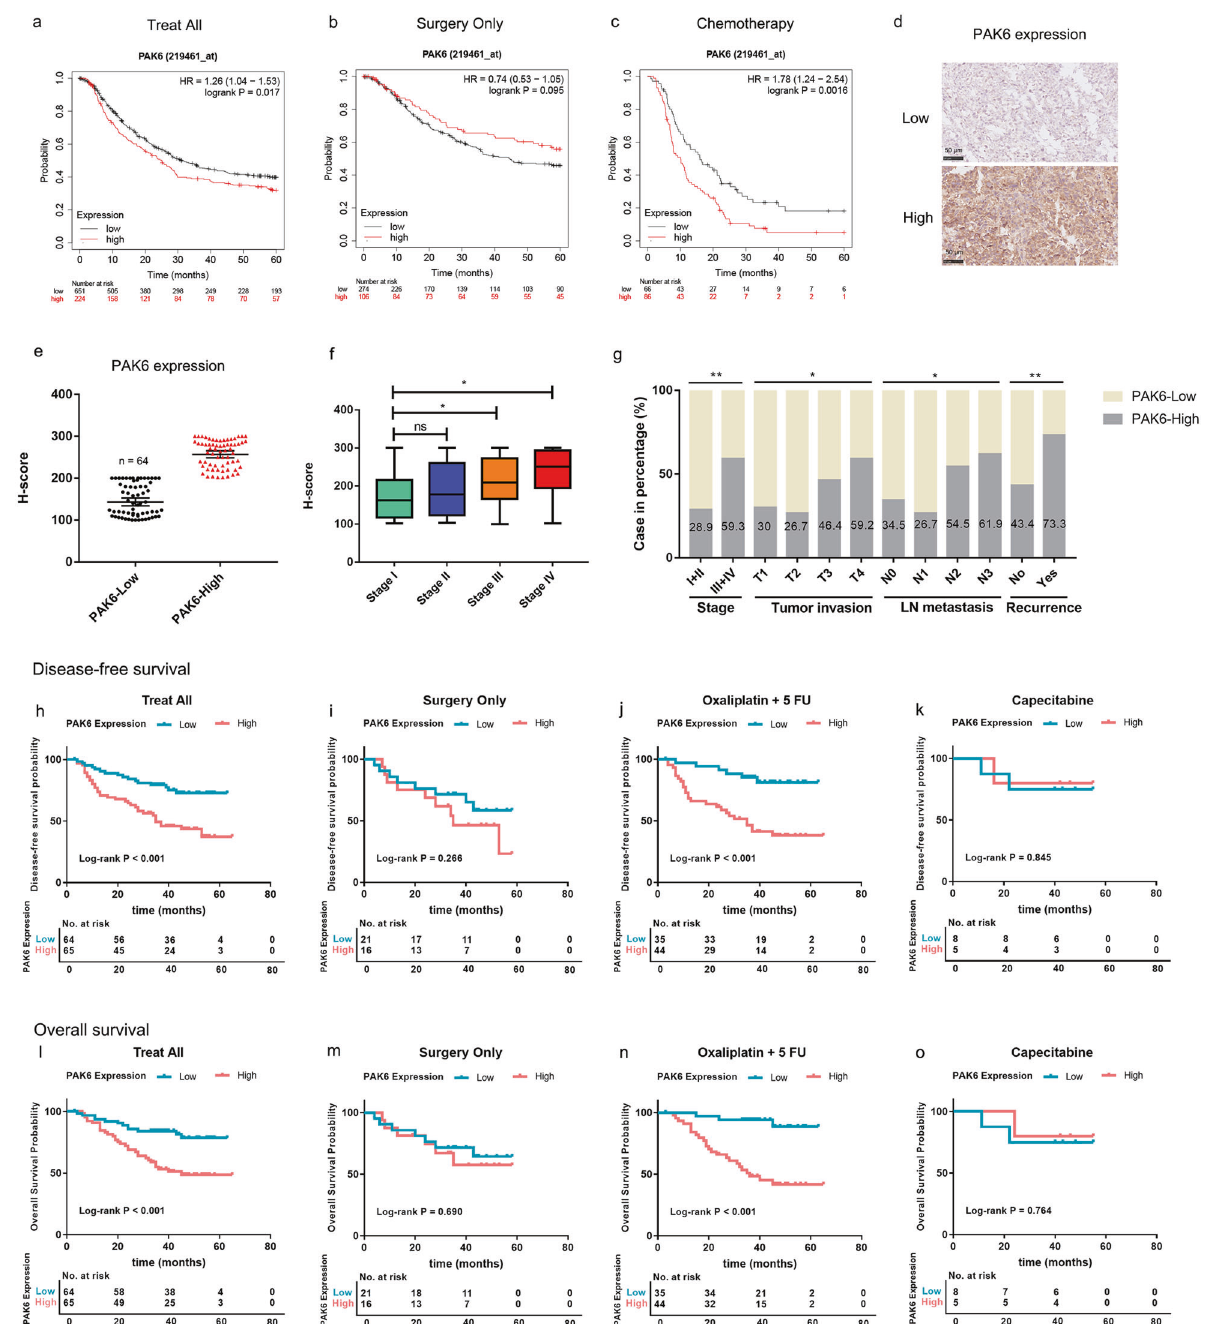
Fig. 1 PAK6 is associated with poor prognosis and the therapeutic ef fi cacy of oxaliplatin in GC. a Kaplan – Meier survival curves of GC patients with PAK6 expression in the KM-Plotter database (www.kmplot.com). b Subgroup survival analysis according to the PAK6 expression with GC patients treated with surgery only in the KM-Plotter database. c Subgroup survival analysis of PAK6 expression with GC patients treated with chemotherapy in the KM-Plotter database. d Representative graphs of PAK6 expression (high expression and low expression) in the tumor tissues. e Quanti fi cation of the immunohistochemical staining intensity of the PAK6 expression in GC patients. f Quanti fi cation of immunohistochemical staining intensity of the PAK6 expression in different TNM stages. g Percentage of GC patients with high PAK6 expression in the groups classi fi ed by TNM stage, tumor invasion, lymph node metastasis, and recurrence. h Kaplan – Meier survival curves of disease-free survival of the GC patients according to the PAK6 expression. i Subgroup survival analysis of disease-free survival of GC patients treated with surgery only according to the PAK6 expression. j Subgroup survival analysis of disease-free survival of GC patients treated with chemotherapy of oxaliplatin/5 FU after surgery according to the PAK6 expression. k Subgroup survival analysis of disease-free survival of GC patients treated with chemotherapy of capecitabine after surgery according to the PAK6 expression. l Kaplan – Meier survival curves of overall survival of the GC patients according to the PAK6 expression. m Subgroup survival analysis of overall survival of GC patients treated with surgery only according to the PAK6 expression. n Subgroup survival analysis of overall survival of GC patients treated with chemotherapy of oxaliplatin/5 FU after surgery according to the PAK6 expression. o Subgroup survival analysis of overall survival of GC patients treated with chemotherapy of capecitabine after surgery according to the PAK6 expression. *: P < 0.05, **: P < 0.01, ns: no statistical difference.